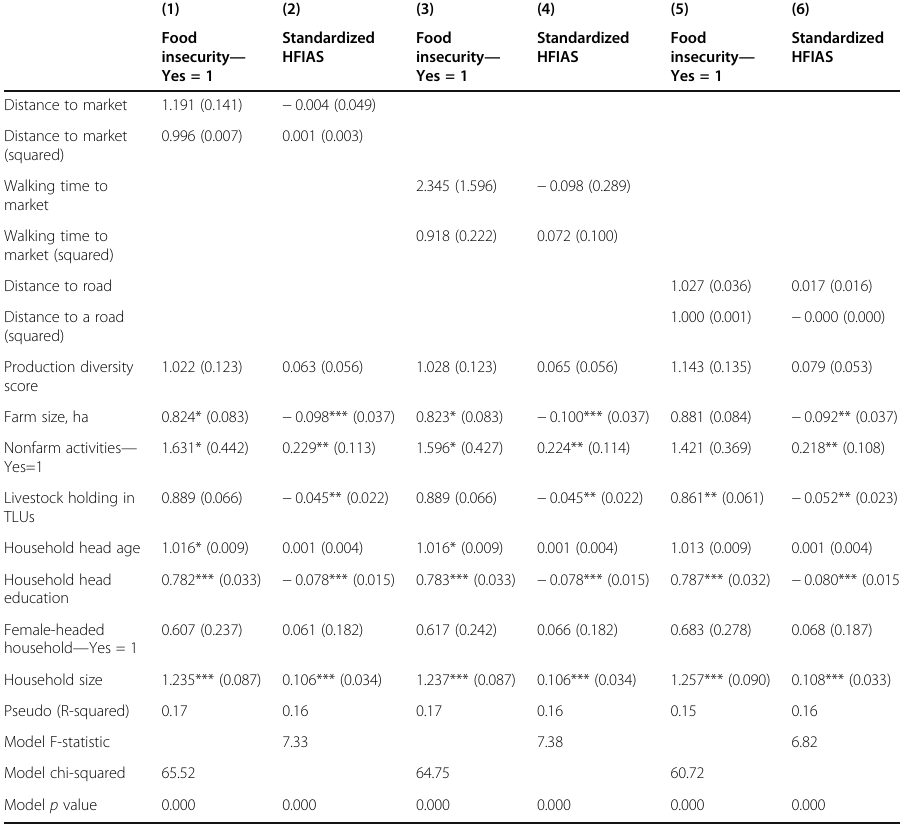
Table 4 Association between market access and food security for 324 smallholder